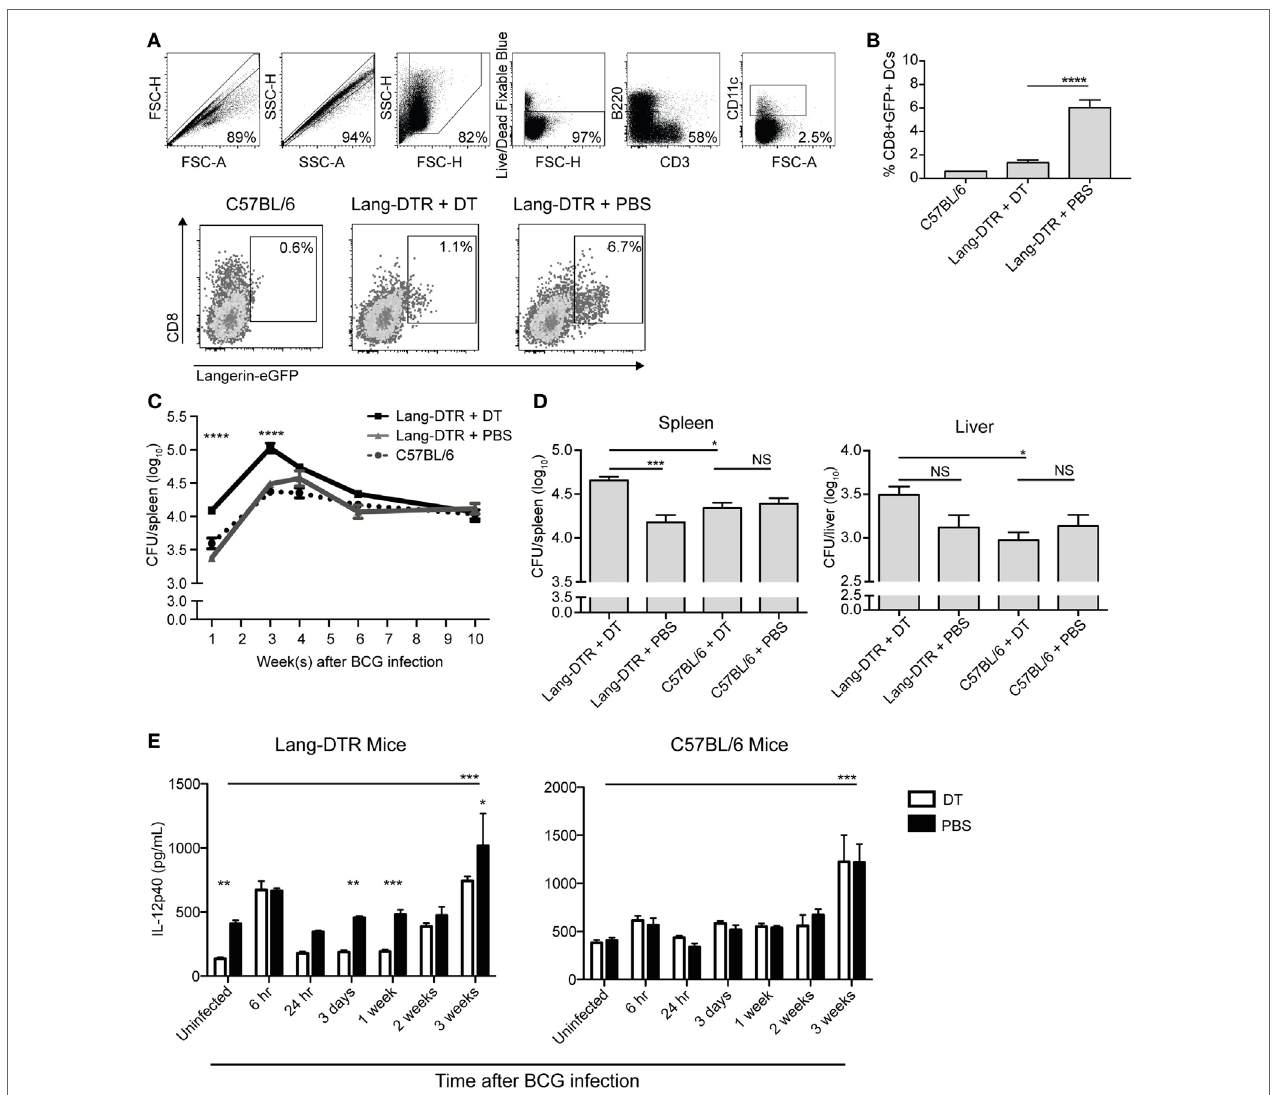
FigUre 1 | Serum IL-12p40 is decreased, and splenic bacterial burden increased, in the absence of langerin + CD8 α + dendritic cells in bacille Calmette– Guerin (BCG)-infected mice. Mice were treated with 350 ng diphtheria toxin (DT) i.p. (or PBS as a control) every 2 days from day − 2 to day 6 after BCG infection. (a,B) Day 7 after BCG infection, GFP expression in the spleens of lang-DTR × lang-EGFP mice and C57BL/6 controls was assessed by flow cytometry after gating on live CD3 − B220 − CD11c + cells ( n = 5 mice per group). **** p < 0.0001, one-way ANOVA. The results are representative of two pooled experiments. (c,D) On day 0, all groups of mice were infected with BCG i.v. At the times indicated, mice were culled and spleens and livers removed, homogenized, and plated on 7H11 agar. Colonies were counted after 2–3 weeks. (c) Spleens were then harvested from mice culled at 1, 3, 4, 6, and 10 weeks after BCG infection ( n = 5–6 mice per group). **** p < 0.0001, two-way ANOVA between DT and PBS groups. (D) In an additional experiment, spleens and livers were harvested from mice culled 3 weeks after BCG infection ( n = 10 mice per group). The results are representative of two independent experiments. * p < 0.05, *** p < 0.001, NS, not significant. (e) Mice were infected with BCG i.v. on day 0. At the times indicated, mice were tail-bled and serum IL-12p40 was measured by ELISA ( n = 4–8 mice per group). * p < 0.05, ** p < 0.01, *** p < 0.001, two-way ANOVA between DT and PBS-treated groups, *** p < 0.001, one-way ANOVA between uninfected and 3-week PBS-treated